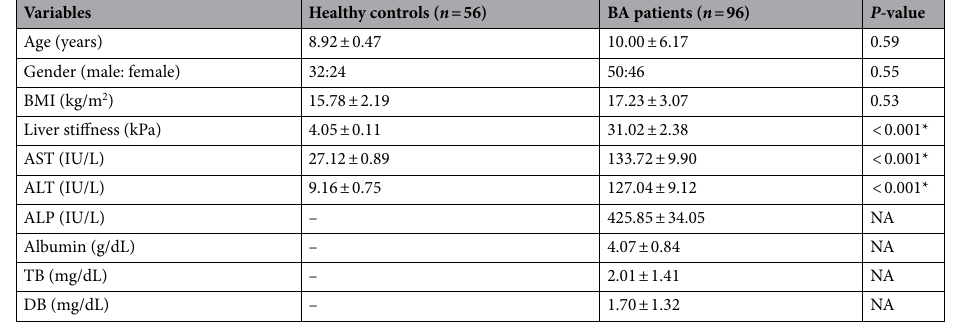
Table 1. Baseline and clinical characteristics of study participants. ALP alkaline phosphatase, ALT alanine aminotransferase, APRI AST to platelet ratio index, AST aspartate aminotransferase, BA biliary atresia, BMI body mass index, DB direct bilirubin, TB total bilirubin, NA not available. *Difference is considered statistically significant at P -value less than 0.05